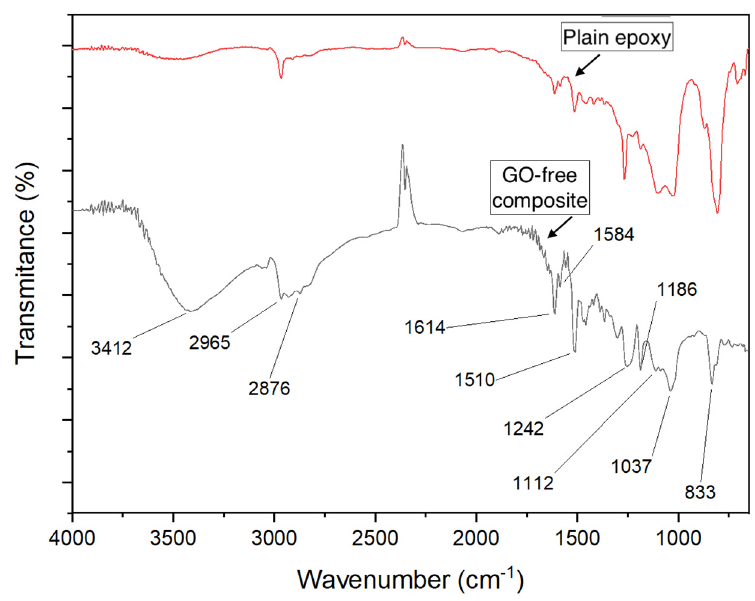
Figure 10. FTIR spectra of plain epoxy and GO-free 30 vol% ramie fabric epoxy composite.